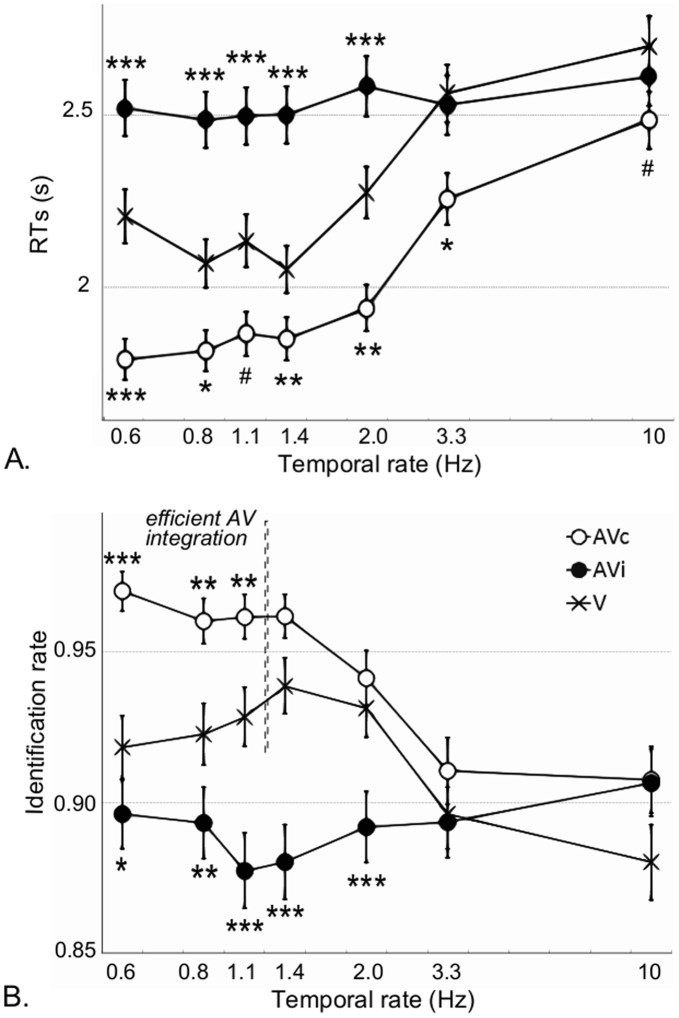
Main effect of temporal rates collapsed across all set sizes on reaction times and identification rate.Mean response times (A) and detection rates (B) per condition (V: crosses, AVc: filled circles and AVi: open circles). Bars denote are two SEM. A sound synchronized with the visual target color change fastens RTs for all temporal rates (Fig. 3a) and improves target detection only below 1.4 Hz (Fig. 3b). The level of significance between AV (AVc and AVi) and V conditions are reported as follows: *p<0.05; **p<0.01; ***p<0.001, #p<0.055.